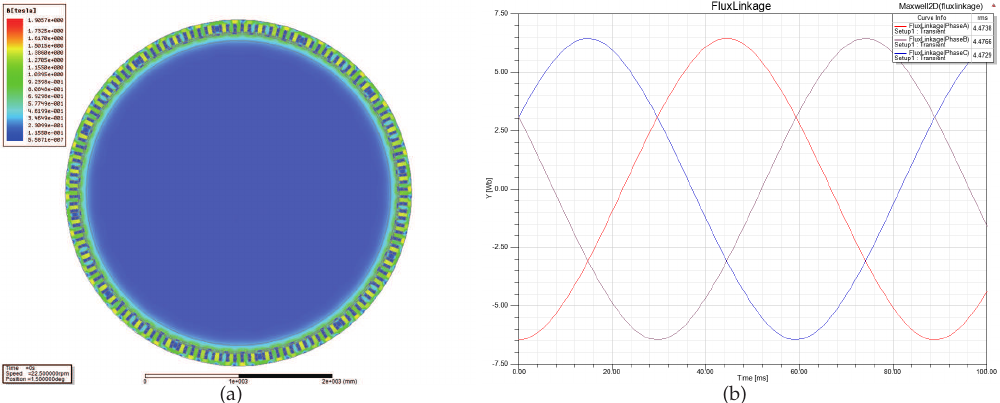
Figure 10. Results of finite element analysis with ψ f ≈ 4.47 Wb in Case 2 : ( a ) Nephogram of magnetic flux density; ( b ) Corresponding waveform of magnetic flux